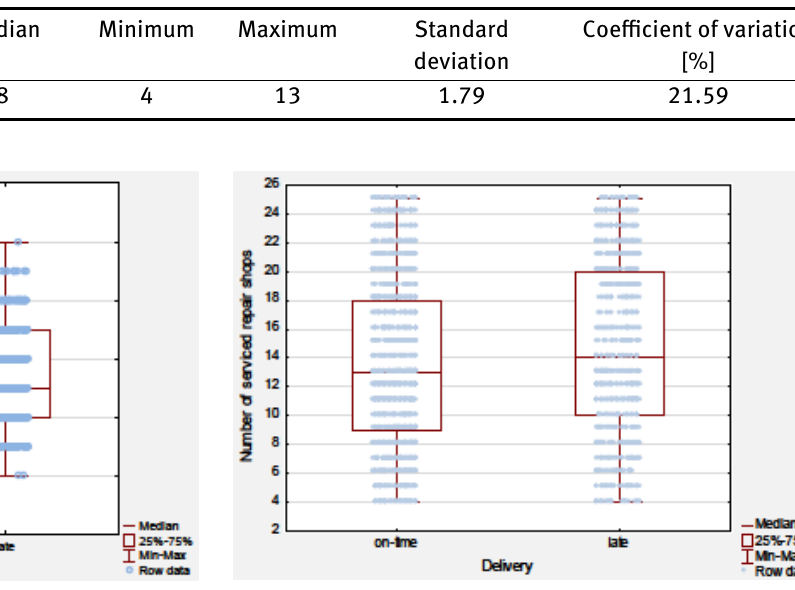
Figure 3: Comparison of delivery timeliness depending on the number of serviced repair